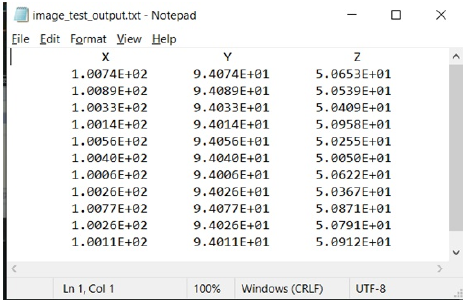
Figure 7. Post-processing data structure from image tests.